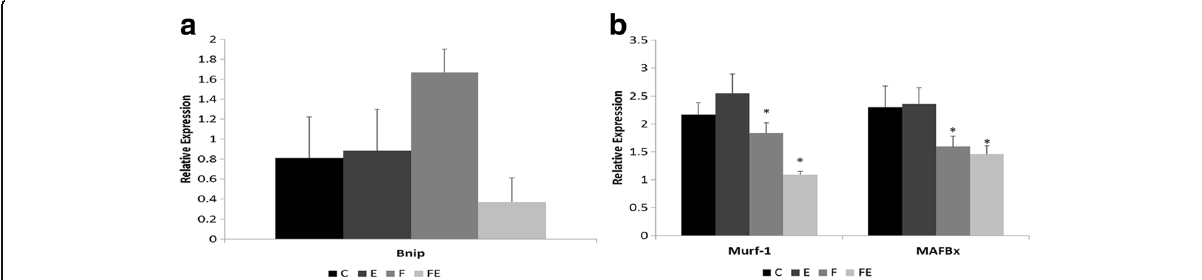
Fig. 4 Impact of fructose ingestion and exercise on expression of a mitophagy marker Bnip3 and b E3 ubiquitin ligases Murf-1 and MAFBx. Groups: C control, E exercise, F fructose, FE fructose + exercise. Results are presented as mean ± SEM. There is a main effect of fructose ingestion on expression of Murf-1 and MAFBx (see the text for more